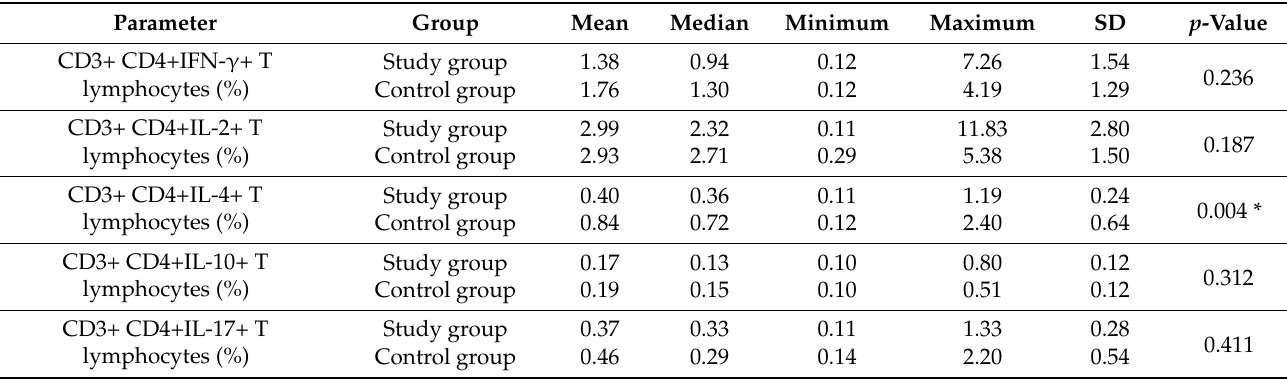
Table 3. Evaluation of the percentage of CD3+CD4+ lymphocytes with intracellular expression of selected cytokines in the study group and the control group.